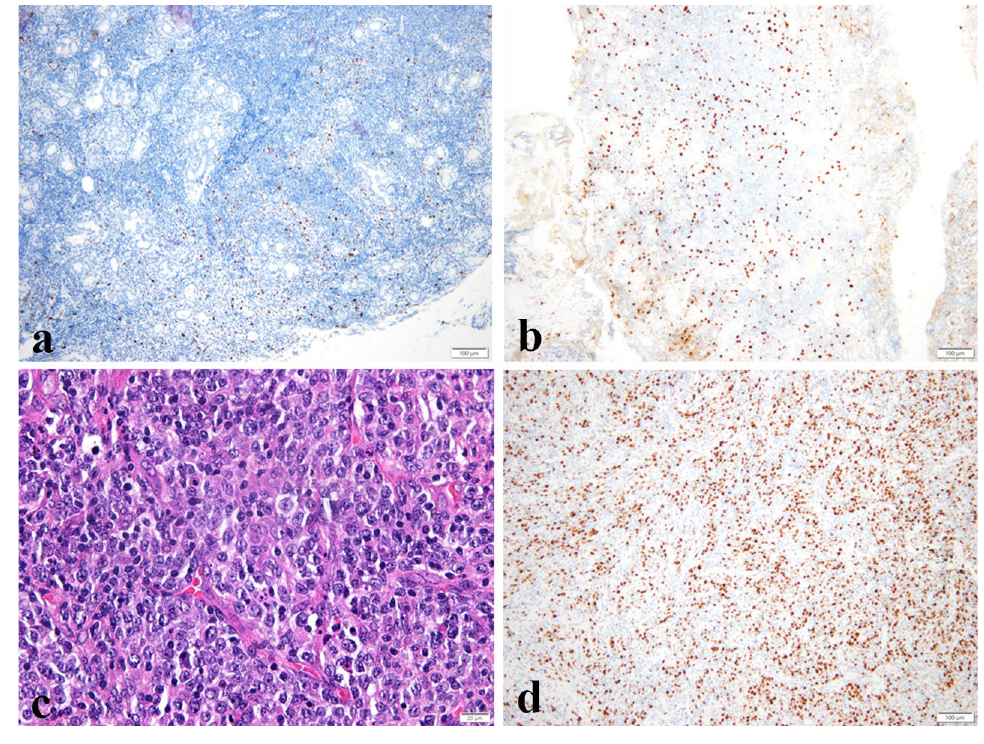
Figure 2. Images of Ki-67 index in case6, and diffuse large B cell lymphoma transformed case7. ( a , b ) Immunohistochemistry staining for Ki-67 shows nuclear positivity in 5% of tumor cells in the initial slide but is increased to 30% in the recurred slide in eyelid. (Ki-67, a; ×100, b; ×100), ( c , d ) Transformed cells are scattered between small lymphoid cells and Ki-67 staining shows increment. (H&E, a; ×400, Ki-67, b; ×100).